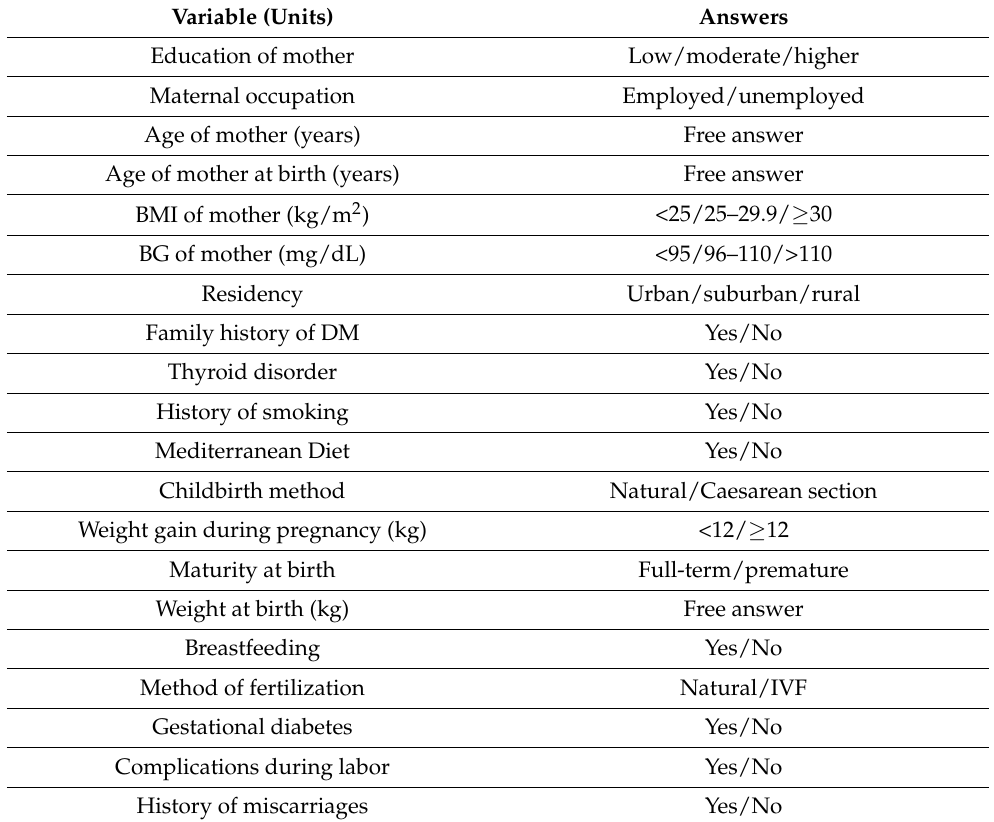
Table 1. Questionnaire regarding parental factors. BMI: body mass index; BG: blood glucose; DM: diabetes mellitus; and IVF: in vitro